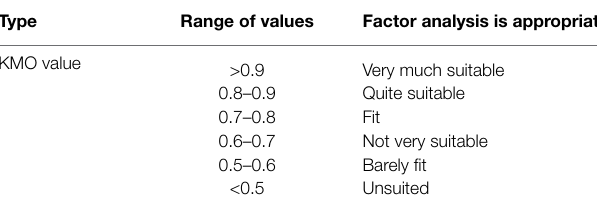
TABLE 1 | Kaiser Meyer Olkin (KMO) test